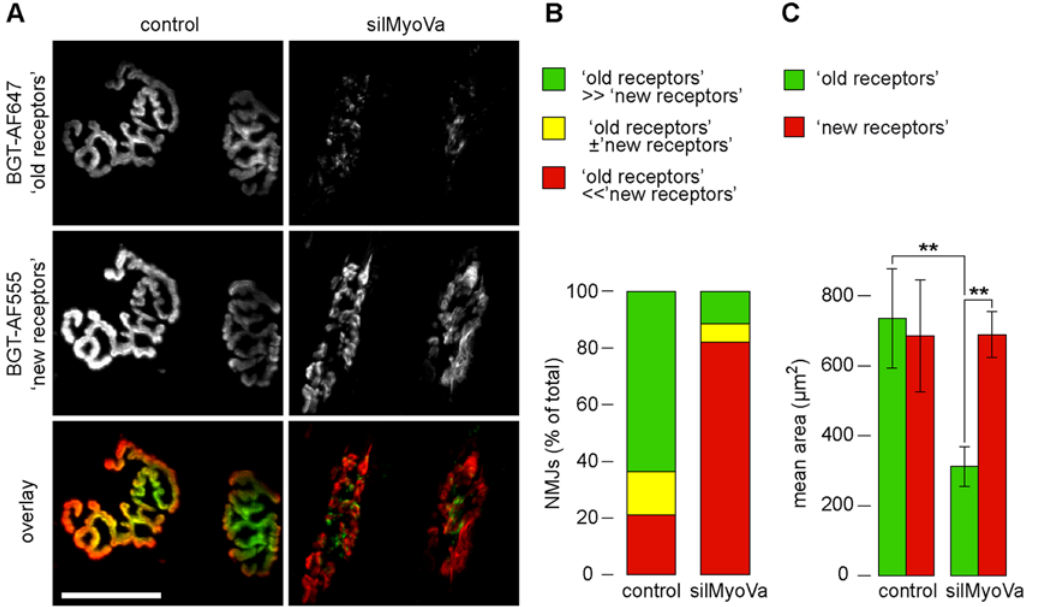
Figure 6. Persistence of AChRs in NMJs is reduced in muscles transfected with silMyoVa in vivo. TA muscles of adult wildtype mice were either transfected with rapsyn-GFP (control) or co-transfected with rapsyn-GFP and silMyoVa (silMyoVa). Simultaneously, muscles were locally injected with BGT-AF647. Ten days later, transfected muscles were locally injected with BGT-AF555 and then imaged using in vivo confocal microscopy. A: Maximum z-projections of 13 (control) and 7 (silMyoVa) optical slices taken at 2 m m interslice distance encompassing the entire extensions of shown NMJs in depth. Overlay image, BGT-AF647 (green), BGT-AF555 (red), co-localisation (yellow). Scale bar, 50 m m. B: Quantification of NMJs exhibiting a ratio of BGT-AF647 to BGT-AF555 volume signals smaller than 0.8 (‘old receptors’ % ‘new receptors’), 0.8–1.2 (‘old receptors’ 6 ‘new receptors’) or higher than 1.2 (‘old receptors’ & ‘new receptors’). Data are from 34 (control) and 61 (silMyoVa) NMJs (4 animals per condition). C: Determination of BGT-AF647 (‘old receptors’) and BGT-AF555 (‘new receptors’) positive areas in individual NMJs. Data, mean 6 s.e.m. (control, n=15 NMJs; silMyoVa, n=24 NMJs, from 2 different animals each).